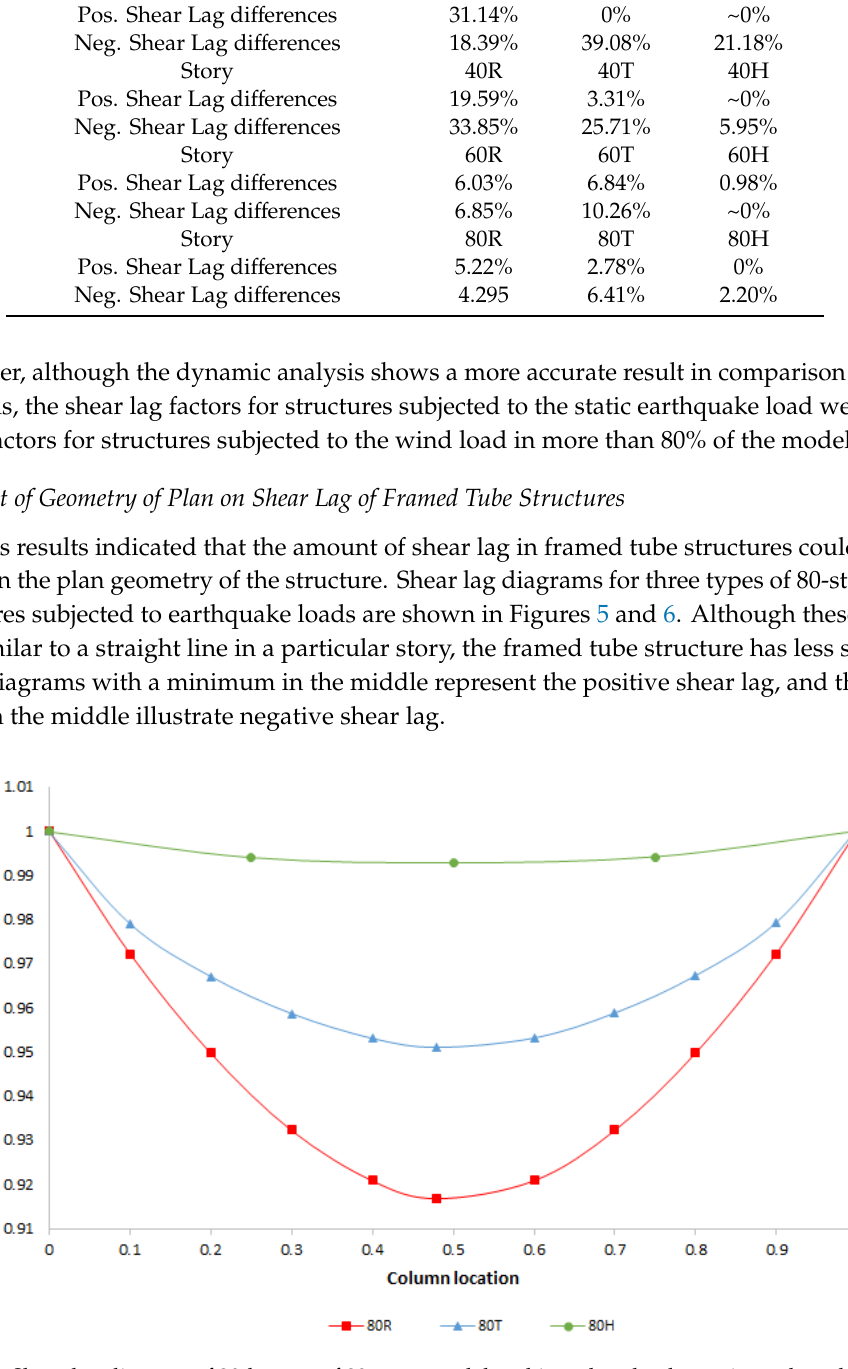
Figure 6. Shear lag diagram of 60th story of 80 story models subjected to the dynamic earthquake load. According to these diagrams, it is observed that hexagon shaped plan structures have a better performance in terms of shear lag in comparison with the other two shapes. This structural behavior is in line with a previous study conducted by Awida, who stated that the octagon shape as a plan geometry can be the best in the structural response against wind load in comparison with other possible plan geometries [30]. Triangular-shaped structures act much better against lateral loads than rectangular ones which have the most inequality of load distribution in their flange columns. In addition, shear lag factors for every 10 stories in all structures were obtained, and the average of positive and negative shear lag factors for each structure was calculated as shown in Table 4. This table shows a similar trend in the case of shear lag in all structures. For instance, in terms of positive shear lag of a dynamic earthquake load, the 80H model acted 8.2% better than the 80R model. Moreover, the 80T model had 3.6% less shear lag in comparison with 80R. Furthermore, the negative shear lag factor of the 80H and 80T models—23% and 10.2%, respectively—performed better than the 80R model.